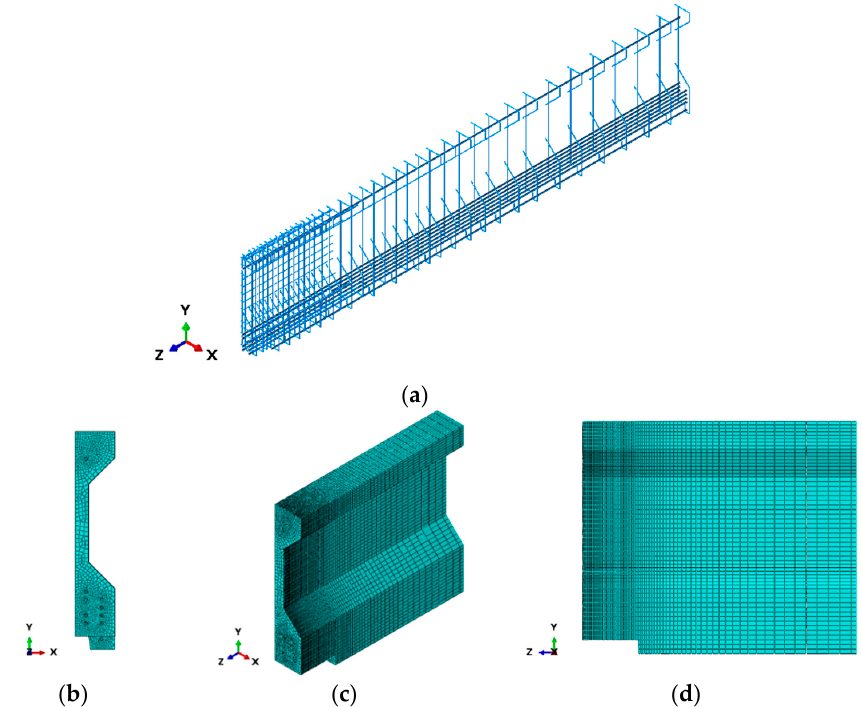
Figure 3. FE model of the tested girder, prestressing strands and passive reinforcement: ( a ) Rebar and strand configuration; ( b ) End face; ( c ) Isometric view; ( d ) Lateral view.